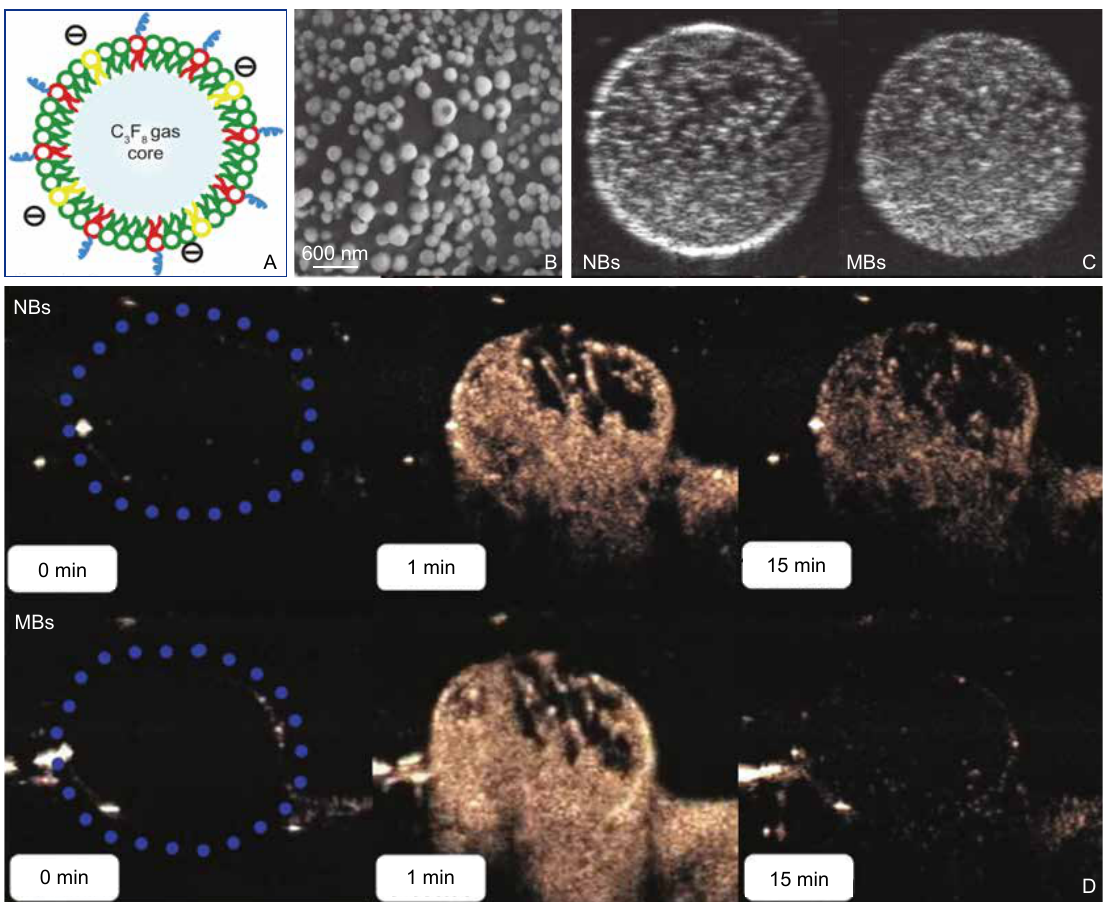
Figure 1 The NBs for ultrasound imaging. (A) Structure of the NBs; (B) Surface morphology of the NBs as visualized using scanning electron microscopy; (C) Representative in vitro ultrasonic images of NBs and MBs at concentration of 8.0×10 5 bubbles/ml, which shows that NBs exhibit better ultrasound contrast ability than MBs; (D) Representative subcutaneous tumor images before (blue dotted line) and after the injection of NBs compared with MBs at various time points (0, 1, and 15 minutes). The NBs exhibit longer contrast-enhanced time than MBs. (Reproduced with permission from